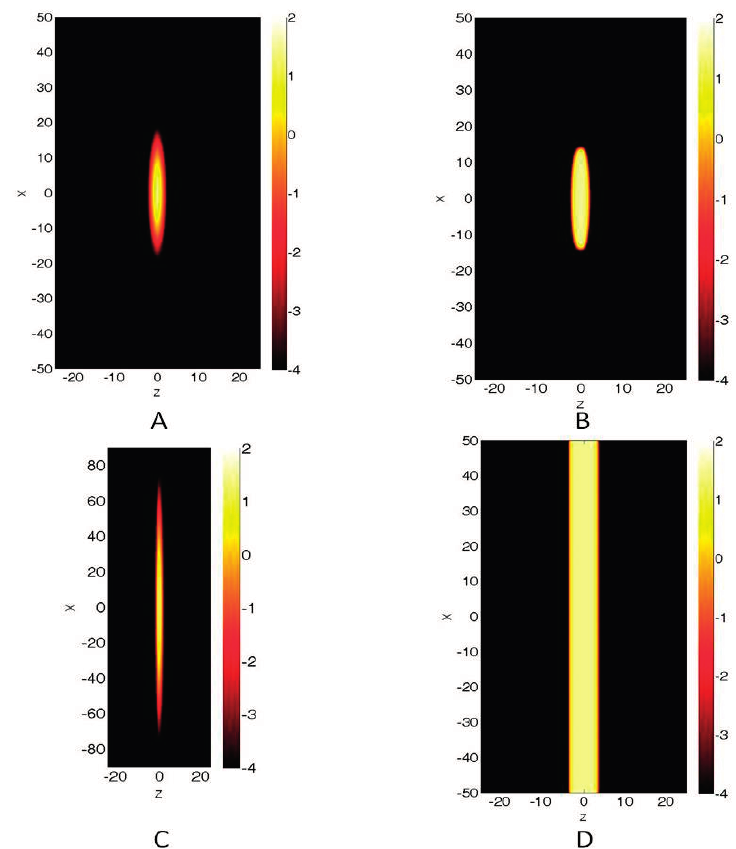
Figure 6. Various whisker models considered in the simulations, with the following properties: ( A ) ellipsoidal shape and density gradient; ( B ) ellipsoidal shape and constant density; ( C ) density gradient and approximately planar shape; ( D ) constant density and planar shape. X, Y axes are in μ m. Color map scale is logarithmic normalized related to the critical density.